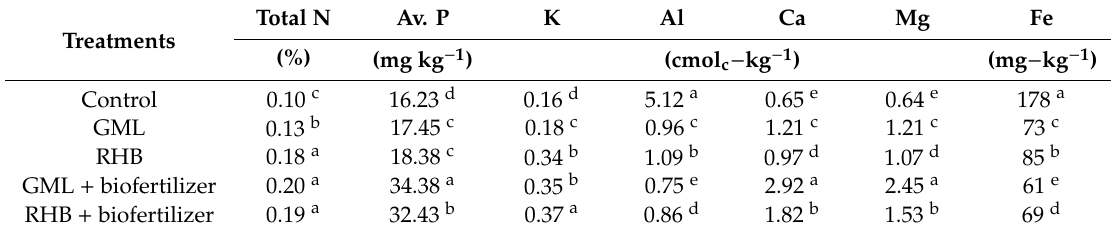
Table 5. E ff ects of applying amendments on nutrients of the acid sulfate soil.